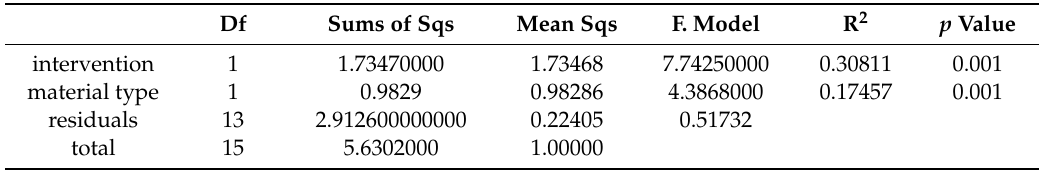
Table 1. Permutational Multivariate Analysis of Variance showed that the intervention changed the community composition of bacteria in the daycare yard at the OTU level and that the bacterial communities in the material types di ff ered (mineral soil, sod, forest floor). Df Sums of Sqs Mean Sqs F. Model R 2 p Value intervention 1 1.73470000 1.73468 7.74250000 0.30811